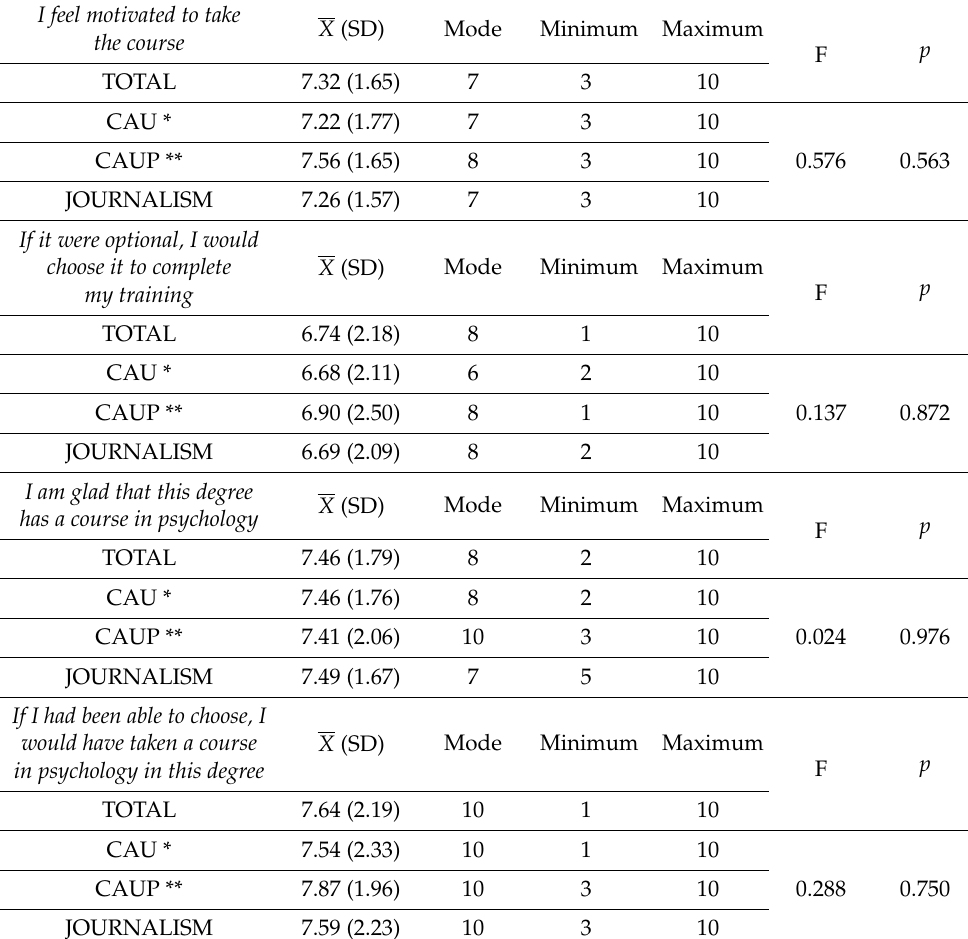
Table 4. Descriptions of items of the attitudes scale and ANOVA